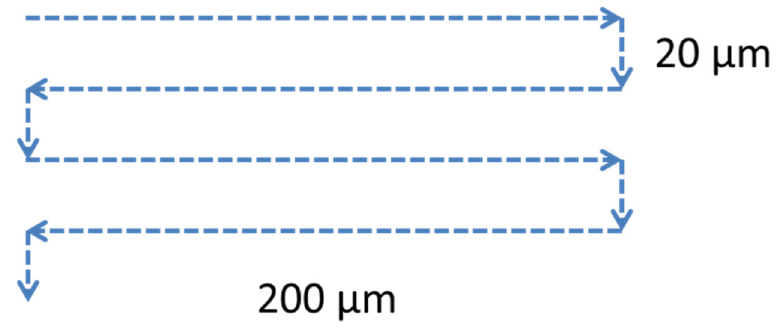
Figure 5. Pattern of the laser beam movement during the irradiation of the cells. The cells were fixed with paraformaldehyde (4% in phosphate buffered saline, pH 7.4) for 20 min at room temperature 30 min after irradiation. Then, they were washed out twice with phosphate buffered saline (pH 7.4). They were permeabilized with 0.3% Triton-X100 in phosphate-buffered saline (pH 7.4) containing 2% bovine serum albumin to block non- specific binding. The slides were incubated with primary antibodies (mouse monoclonal anti-XRCC1 antibody (clone 33-2-5, Abcam, Waltham, MA, USA) and rabbit monoclonal anti- γ H2AX antibody (clone EP854(2)Y, Merck-Millipore, Burlington, VT, USA) at a dilu- tion of 1/200) in phosphate-buffered saline (pH 7.4) containing 1% bovine serum albumin for 1 h at room temperature. Then the slides were washed out with phosphate-buffered saline (pH 7.4) and incubated at room temperature for 1 h with secondary goat anti-mouse and goat anti-rabbit IgG (H+L) antibodies conjugated with Alexa Fluor 488 and Alexa Fluor 555 fluorochromes (Life Technologies, Carlsbad, SA, USA), accordingly. Both anti- bodies were diluted 1/800 in phosphate-saline buffer (pH 7.4) containing 1% bovine serum albumin. DAPI containing ProLong Gold (Life Technologies, Carlsbad, SA, USA) was used to stain DNA and prevent